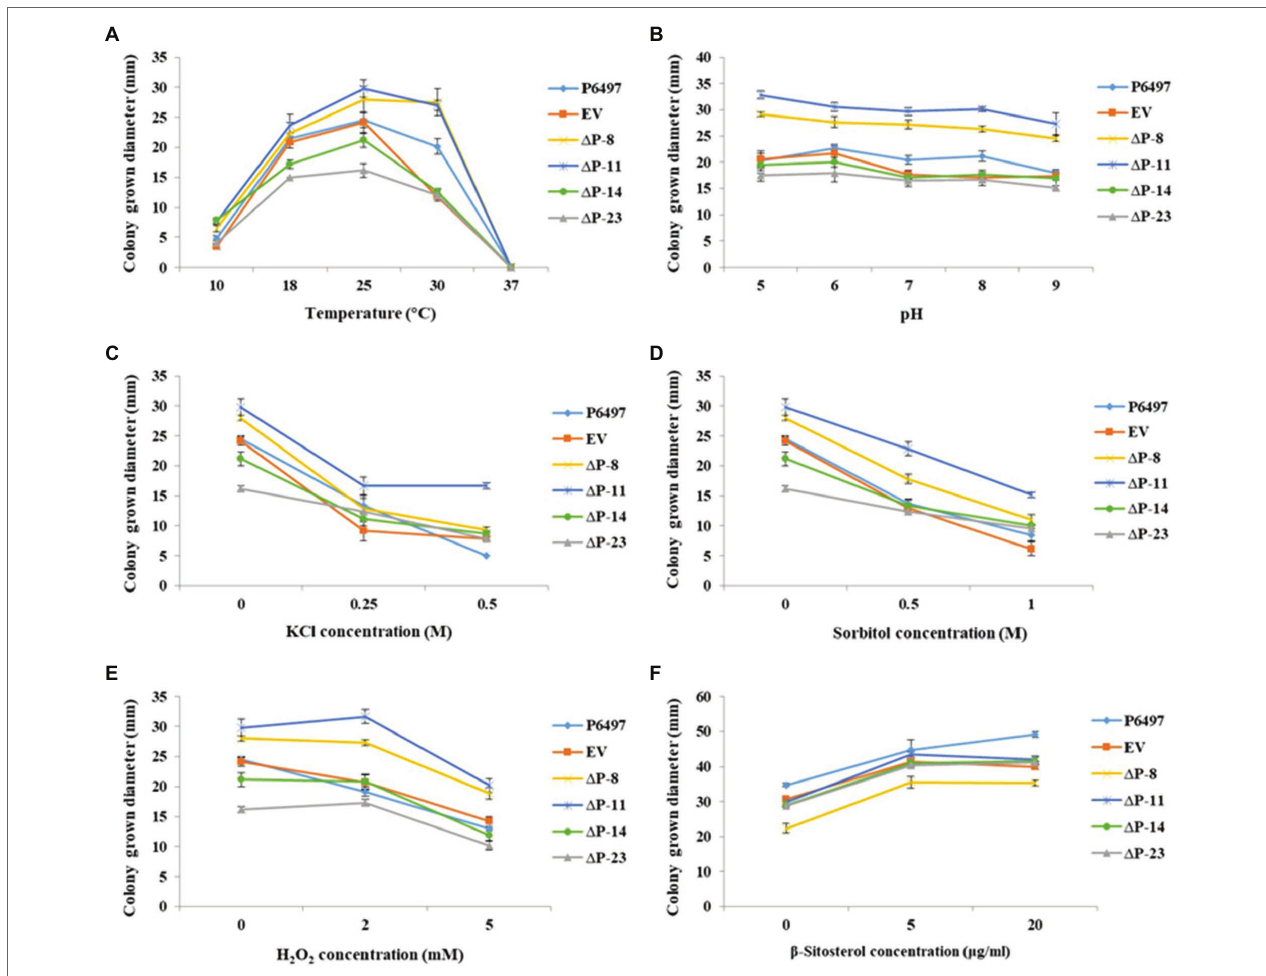
FIGURE 7 | Mycelial growths of PsPTL mutants under different stress conditions and exogenous β -sitosterol. (A) Mycelial growth diameters of the wild-type (P6497), control strain (EV), and PsPTL mutants ( Δ P-8, 11, 14, 23) on Plich medium at 10, 18, 25, 30, and 37 ° C, respectively; (B) and on Plich medium with a pH value of 5, 6, 7, 8, and 9; (C) with 0, 0.25, and 0.5 M KCl; (D) with 0, 0.5, and 1 M sorbitol; (E) with 0, 2, and 5 mM H 2 O 2 , respectively. (F) Mycelial growth diameters of all strains on basal medium amended with 0, 5, and 20 μ g/ml β -sitosterol. Bars indicate